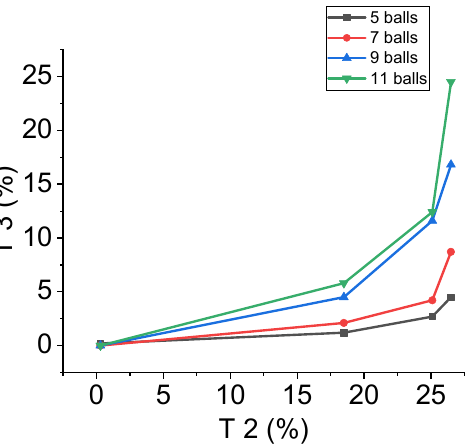
Figure 8. Mass fraction of fines size class against mass fraction of the intermediate size class for different speeds).